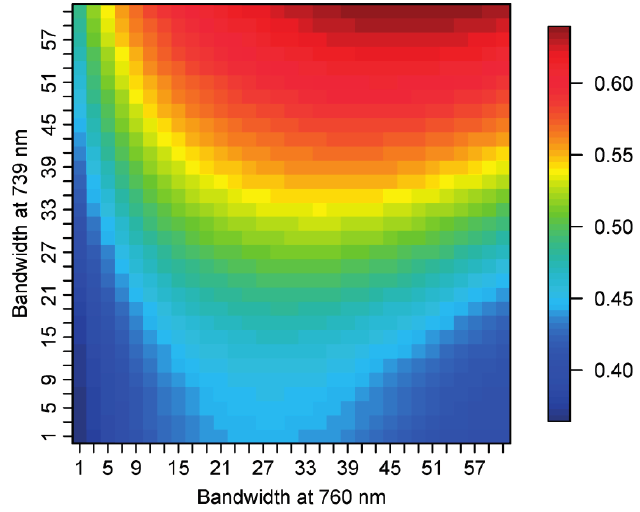
Figure 5. Contour map of RMSE value estimated from predictive model under different bandwidths (1–61 nm) based on the DSI R760–R739